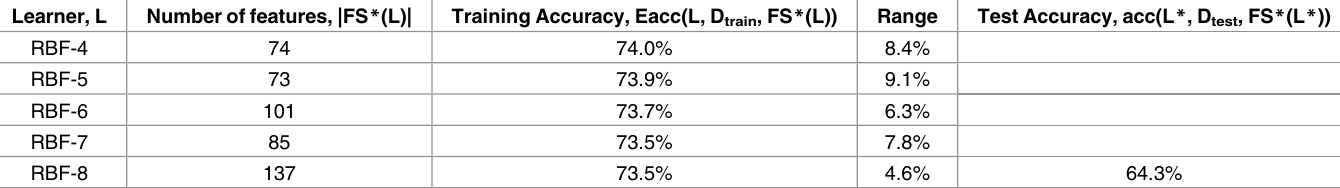
Table 11. ADHD-200,personal characteristic data with functional images.